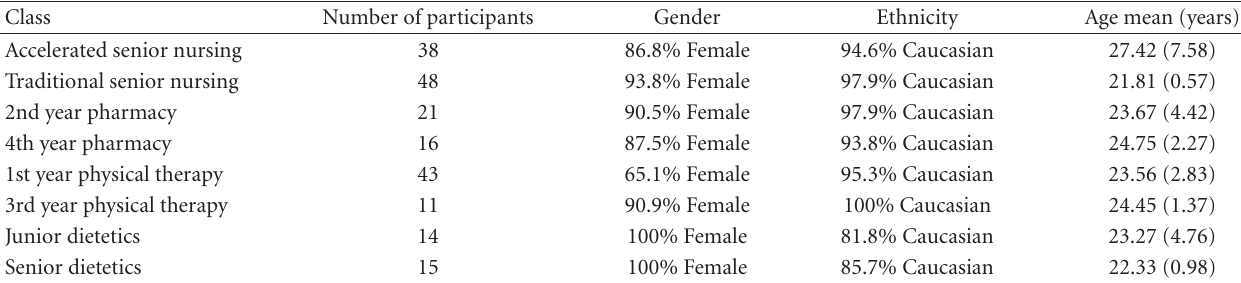
Table 1: Demographic